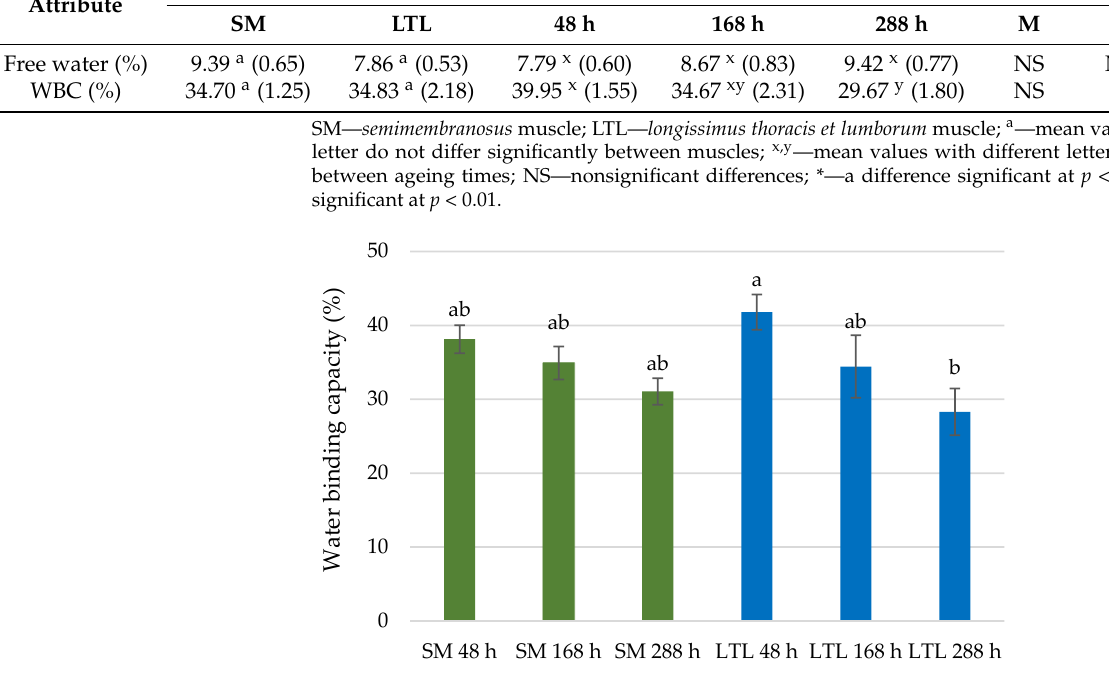
Figure 2. Water binding capacity in semimembranosus (SM) and longissimus thoracis et lumborum (LTL) muscles aged for 48 h, 168 h, and 288 h (a,b—mean values with different letters differ significantly at p < 0.05; vertical bars refer to the standard error of the mean).